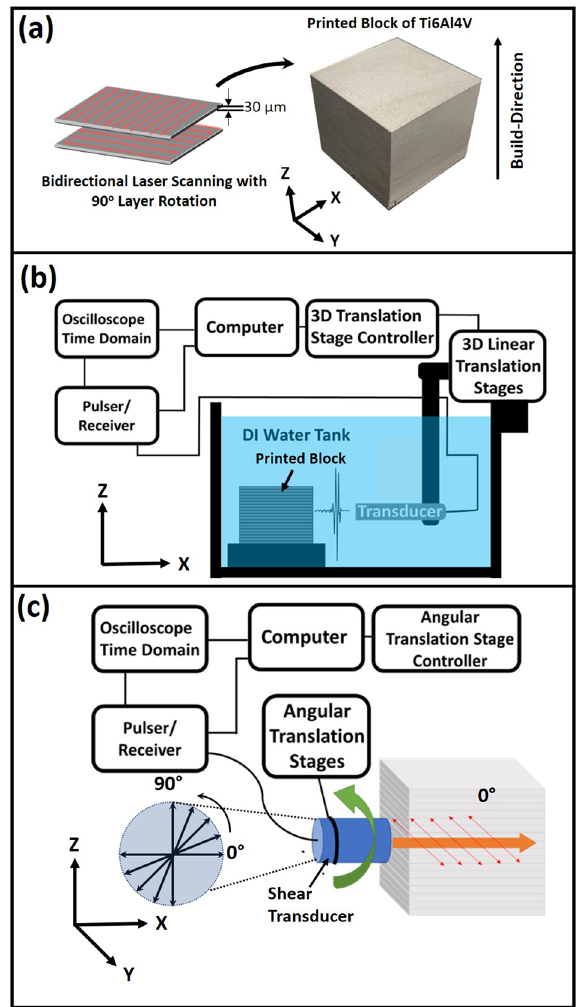
Figure 1. Set of schematics illustrating ( a ) the process of laser powder bed fusion, ( b ) setup for performing elastic bulk modulus elastography, and ( c ) experimental arrangement for measuring velocity of sound using shear